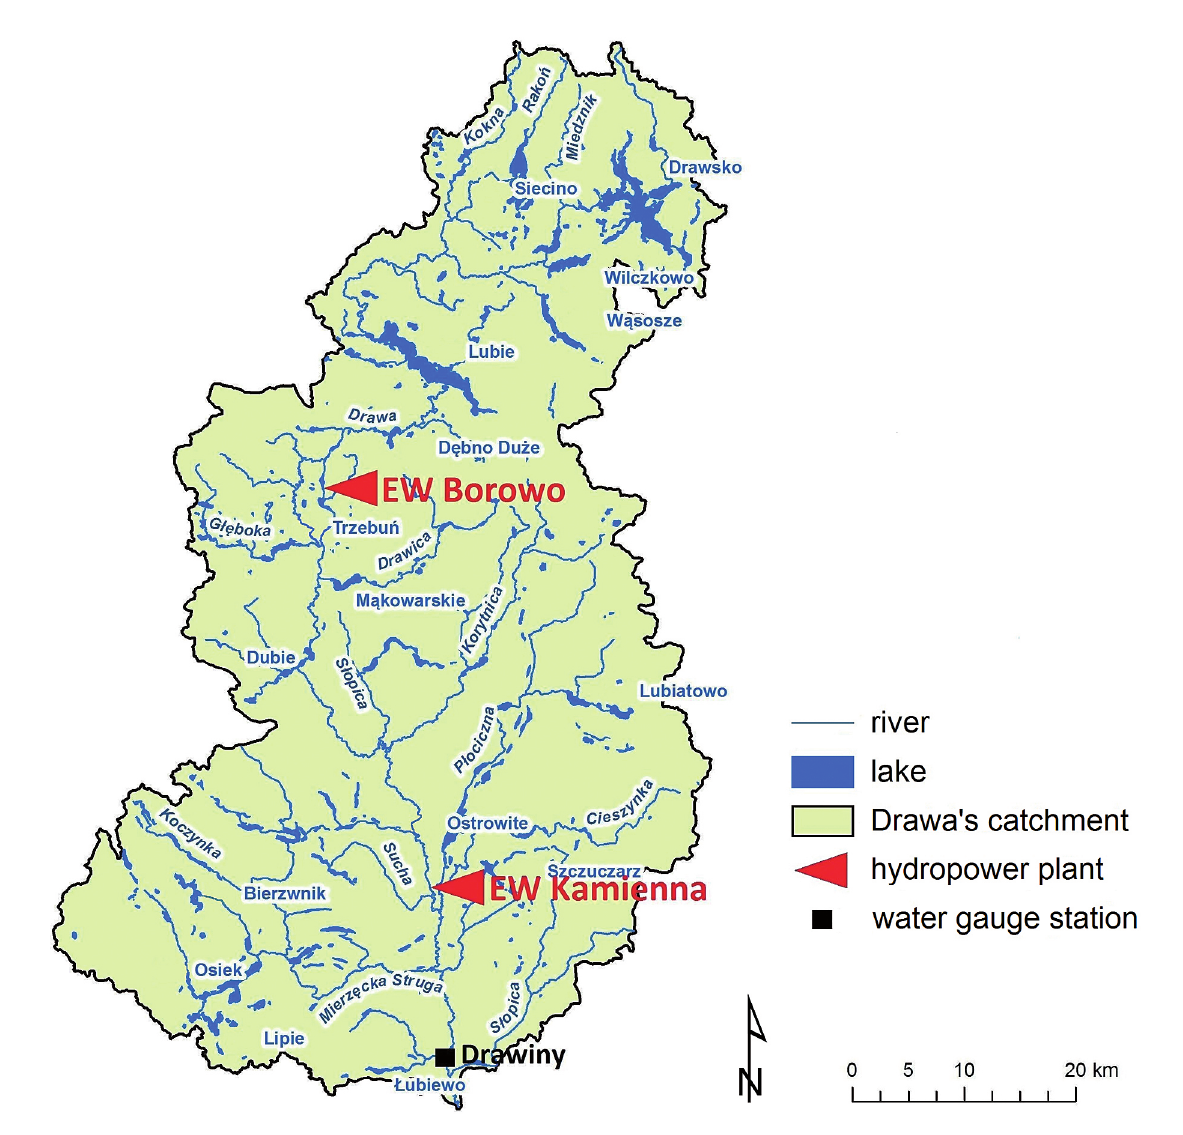
Fig. 2. Locations of hydropower plants on the Drawa